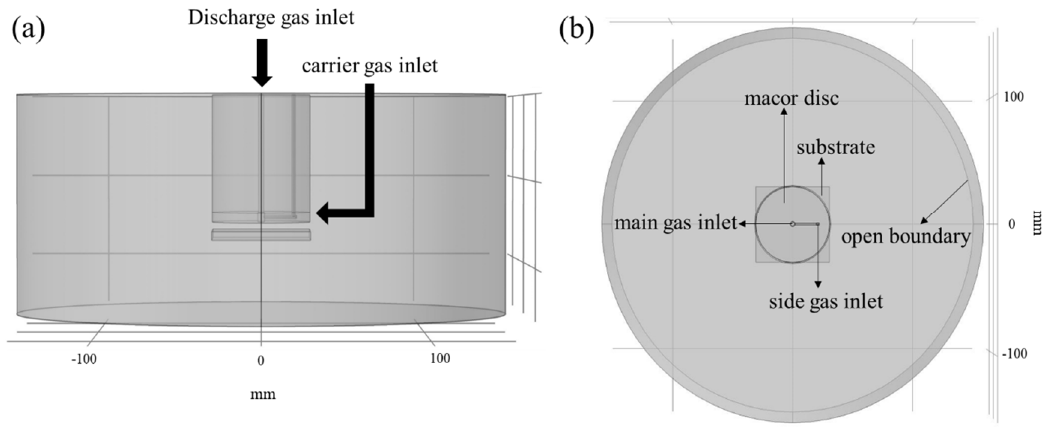
Figure 2. ( a ) XZ-plane and ( b ) XY-plane views of the MW plasma jet geometry.